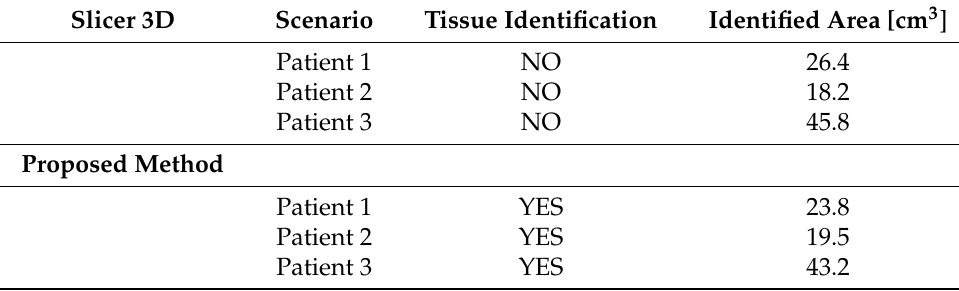
Figure 10. Experimental assessment, third scenario. A patient with an extended brain tumor in the left frontal lobe. Table 1. Results comparisons between the results obtained with the two segmentation